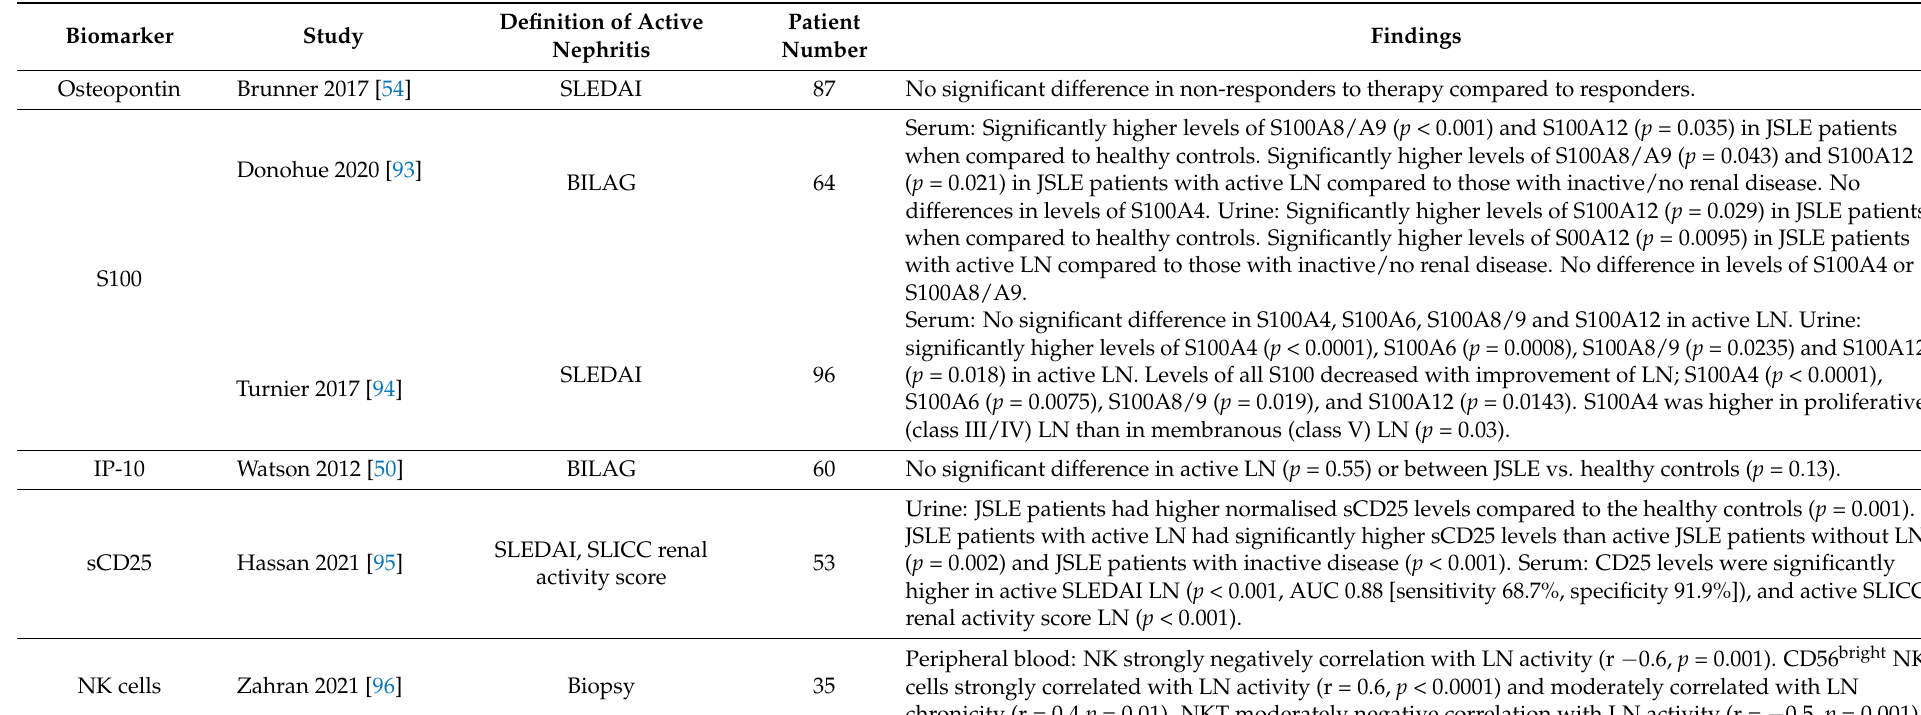
Legend: AUC, area under curve; BILAG, British Isles Lupus Assessment Group; IP-10, interferon gamma-induced protein 10; JIA, juvenile idiopathic arthritis; KIM-1, Kidney Injury Molecule-1; L-FABP, liver-type fatty acid binding protein ; LN, lupus nephritis; NIH-AI, National Institutes of Health-Activity Index; NK, Natural Killer; NKT, Natural Killer T lymphocyte; SDI, Systemic Lupus International Collaborating Clinics/American College of Rheumatology damage index; sCD25, soluble alpha chain of interleukin 2 (CD25); SLEDAI, Systemic Lupus Erythematosus Disease Activity Index; SLICC, Systemic Lupus International Collaborating Clinics; TGF β , Transforming Growth Factor β ; TIAI, Tubulointerstitial Activity Index; VCAM-1, vascular cell adhesion molecule-1; VDBP, vitamin D-binding